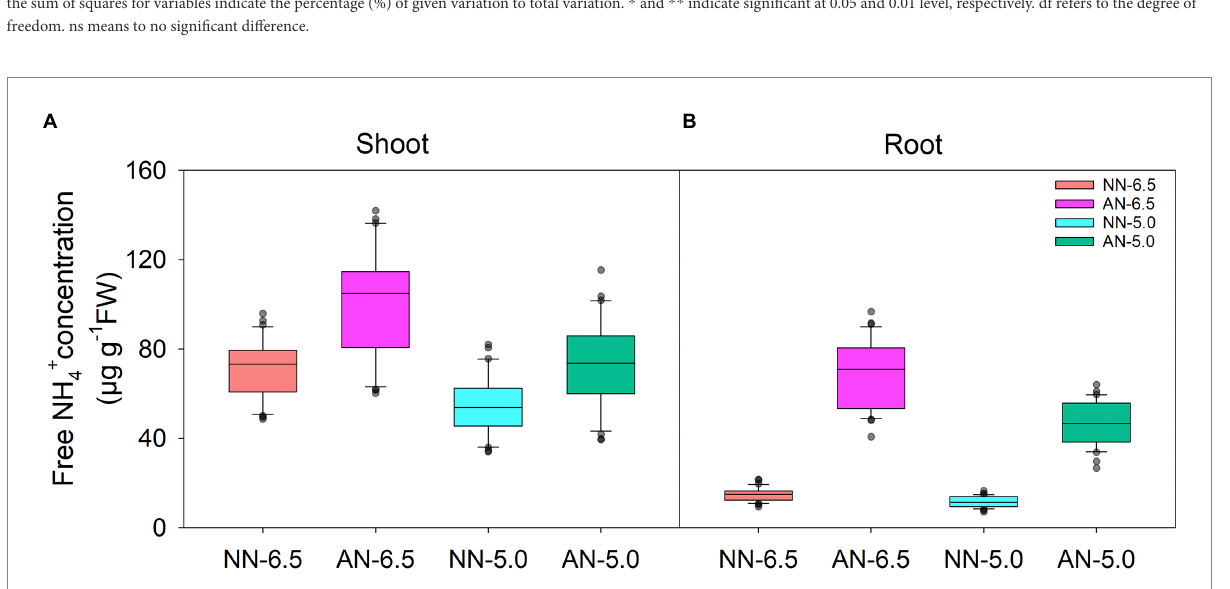
FIGURE 2 The levels of NH 4+ in 31 wheat cultivars grown under different N-sources and pH levels. Data are means ± SE (n = 31). NN-6.5 refers to the nitrate nitrogen at a pH of 6.5; NN-4.5 refers to the nitrate nitrogen at a pH of 6.5; AN-6.5 refers to the ammonium nitrogen at a pH of 6.5; AN-5.0 refers to the ammonium nitrogen at a pH of